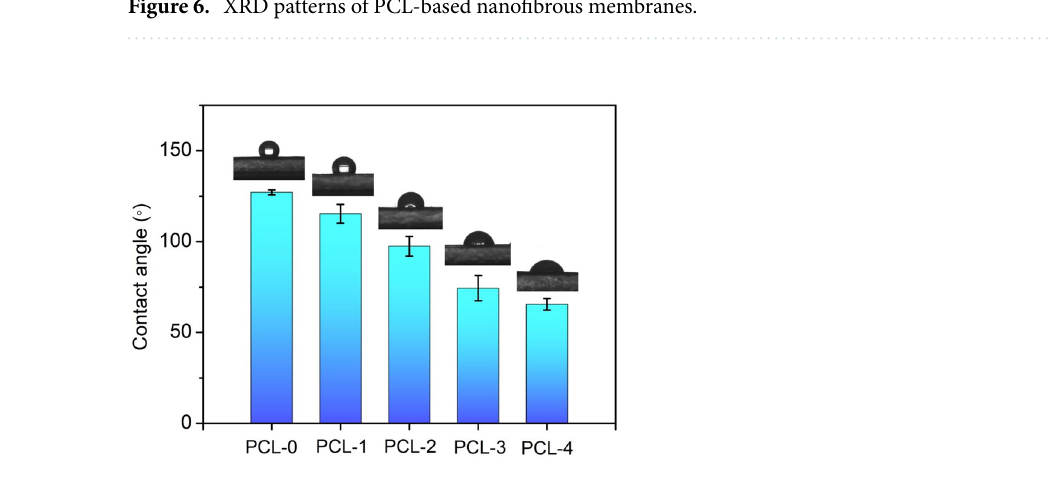
Figure 7. Water contact angle of PCL-based nanofibrous